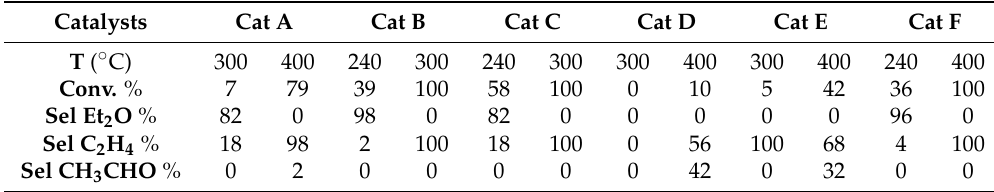
Table 1. Ethanol dehydration on silicalite-1-based